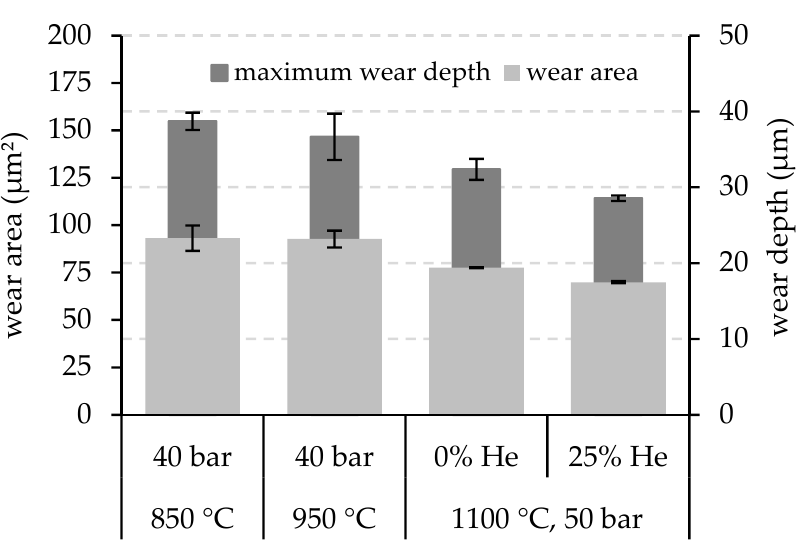
Figure 4. Sections of diffractograms of the untreated and gas-nitrocarburized AISI 316L powders and the CGS coating using 850 °C as well as 1100 °C and 25% He for the main fcc lattice peak. The wear resistance of the CGS coatings was characterized under abrasive conditions in the scratch tests, Figure 5. With increasing temperature and pressure, an increase in wear resistance can be observed. The best results were obtained using 1100 ◦ C and 50 bar with the addition of 25% He. However, the wear resistance of this coating did not exceed that of the HVOF coating [15]. This can be explained by the decrease in the hardness level of the solution-hardened particles. Nevertheless, the results confirm the potential for the improvement of thermally sprayed austenitic steel coatings by using solution-hardened powder feedstock.